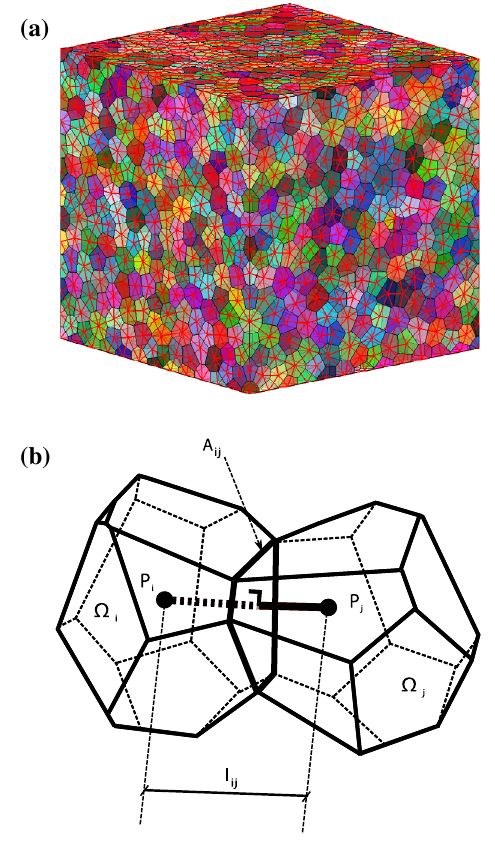
Fig. 12 a Voronoi cell representation of mesostructure of concrete RVE [31]; b voronoi ajdecant cells connected by cohesive